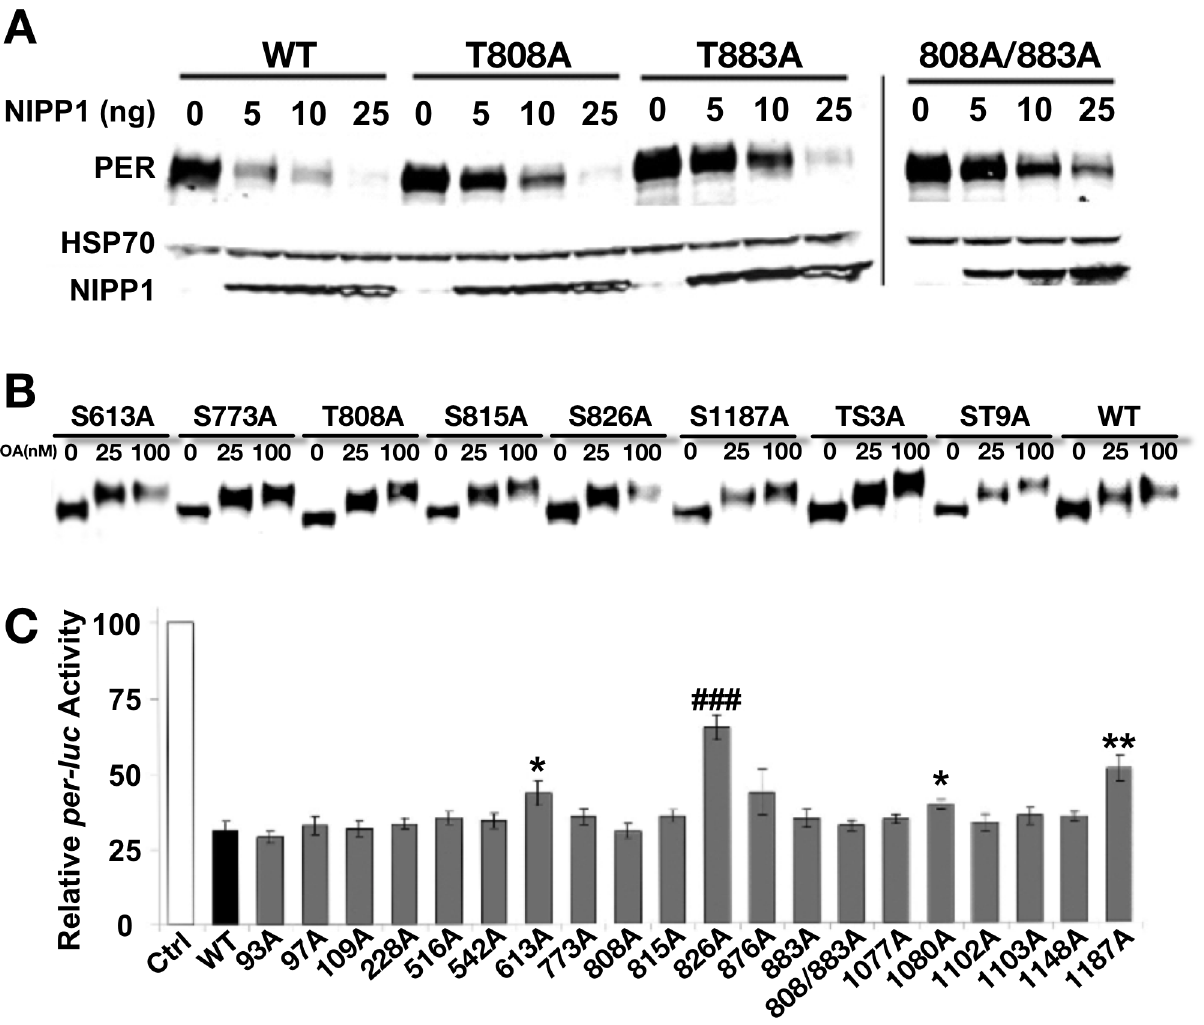
Figure 2. Analysis of PER phosphorylation sites in S2 cells. ( A ) Mutating PP1 target sites increases PER stability. Mass spec screen detected two phosphorylated Threonine (T) residues, T808 and T883, when PP1 was inhibited in the S2R + cells. They were mutated to nonphosphorylatable alanine (A) individually or together in the full-length PER (T808A, T883A and T808A/883A). The response to inhibition of PP1 (by co-transfecting NIPP1) was determined for mutant and wild-type PER (WT). The HSP70 band is shown as a loading control. Inhibition of PP1 induces PER degradation in both WT and mutant PERs, but mutants show a relatively higher tolerance to PP1 inhibition and more so with the T808A/883A double mutant. ( B ) Inhibition of PP2A by increased dosage of Okadaic Acid (OA) induces robust mobility shifts in both WT and all mutant PERs tested, including ones containing up to nine mutated phosphorylation sites. We tested the following individual mutations in this assay and observed the same result: S93A, S97A, S109A, T228A, S516A, S542A, S613A, S773A, T808A, T815A, S826A, S876, T883A, T1077A, S1080A, S1102A, S1103A, S1148A, and S1187A (some data not shown). PER-TS3A includes T763A/T765A/S767A [33] and PER-ST9A includes S756A/T763A/T765A/S767A/S787A/T791A/S795A/S798A/T802A [26]. Proteasome inhibitor MG132 (100 m M) was added to protect phosphorylated PER from degradation. The results shown are representative of two independent experiments. ( C ) Repression activity of WT and mutant PERs in an S2R + cell based per - luciferase ( per-luc ) reporter assay. The graph shows average percent luciferase activity 6 s.e.m, which is normalized to the control cells that were transfected with pAc- clk -HA and per-luc but not pAc- per -HA. This is inversely related to the repression activity of each PER (WT and mutants) transfected. Results are pooled from seven independent experiments and each PER construct was examined independently at least four times. Statistical significance is determined by one-tailed t-test with unequal variance at: P* , 0.01, P** , 0.001, and P ### , 0.000001. Of the mutant dPERs tested, PER-S613A, -T826A, -S1080A and –S1187A display a significant decrease in repressor activity, with PER-T826A exhibiting the most robust change and